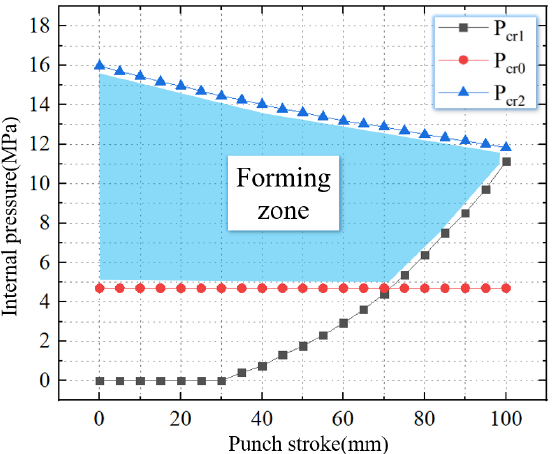
Figure 15. The forming zone of TUBG (thickness-diameter ratio = 1.00%).